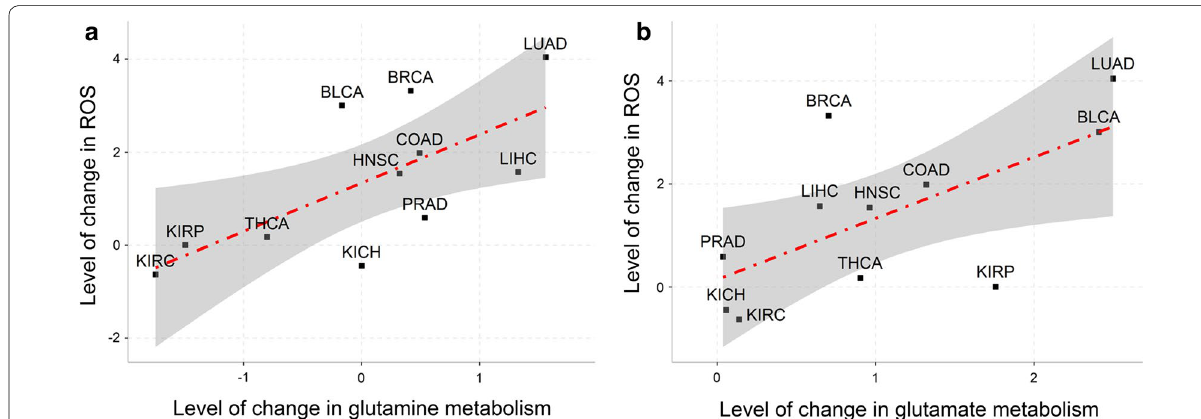
Fig. 6 Strong correlations between the level of change in reactive oxygen species (ROS) and the levels of change in glutamine and glutamate metabolisms across 11 types of cancer. ROS level is correlated with glutamine metabolism ( r ( r 0.655, P 0.029) ( b ). In each panel, the X axis represents the difference between the expression levels of glutamine/glutamate metabolism = = in cancer versus control tissues, and the Y axis represents the difference between the ROS levels in cancer versus control tissues. BLCA, bladder urothelial carcinoma; BRCA, breast invasive carcinoma; COAD, colon adenocarcinoma; HNSC, head and neck squamous cell carcinoma; KICH, kidney chromophobe; KIRC, kidney renal clear cell carcinoma; KIRP, kidney renal papillary cell carcinoma; LIHC, liver hepatocellular carcinoma; LUAD, lung adenocarcinoma; PRAD, prostate adenocarcinoma; THCA, thyroid